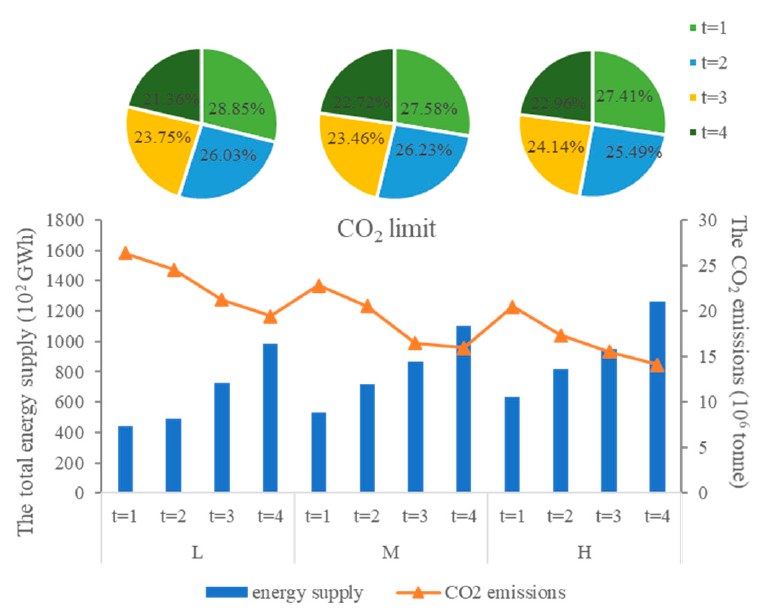
Figure 6. The energy–water–CO 2 synergetic relationship under different